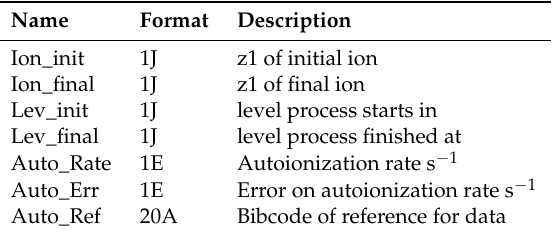
Table A8. APED AI (autoionization) file definition.